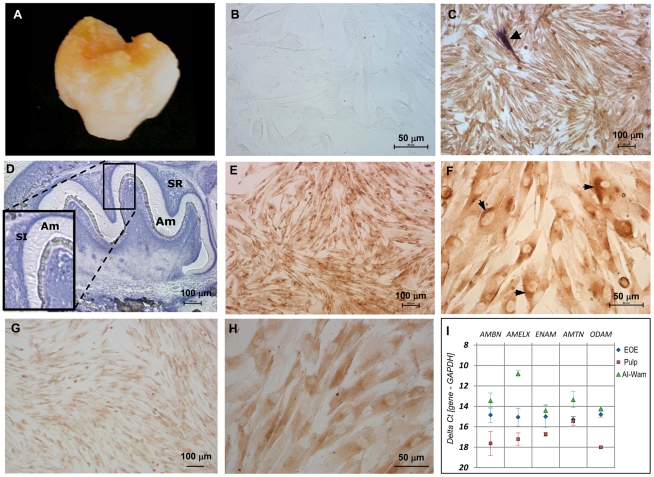
Characterization of the human AI-ameloblast cell population by immunohistochemistry, ALP in situ histochemistry and qRT-PCR analysis.
A. Image of a tooth extracted from an AI patient that was used to establish an EOE primary cell culture. B. Phase contrast image of AI-WAm cell monolayer. C. AI-WAm cells stained for ALP activity followed by immunostaining for the epithelial marker cytokeratin 14; a single, highly ALP-positive cell is evident (arrow). D. Mouse molar stained for ALP activity showing ALP-negative secretory ameloblasts (Am) with highest activity (dark purple) in the stratum intermedium (SI) followed by the stellate reticulum (SR). Low (E) and high (F) magnification of AI-WAm cells positively stained for the major enamel protein Amel. Arrowheads on panel F indicate cells that appear polarized with unidirectional orientation of the Golgi apparatus. Low (G) and high (H) magnification of AI-WAm cells positively stained for the largest enamel protein Enam. I. Quantitative expression levels of the enamel matrix protein genes AMBN, AMELX, ENAM, AMTN and ODAM in AI-WAm cells relative to dental pulp and normal EOE cells as determined by RT-qPCR following normalization to a housekeeping gene GAPDH and presented as ΔΔCt values. Statistical analysis was carried out as described in Materials and Methods. Scale bars are: 50 µm (B, F, H), 100 µm (C, D, E, G).